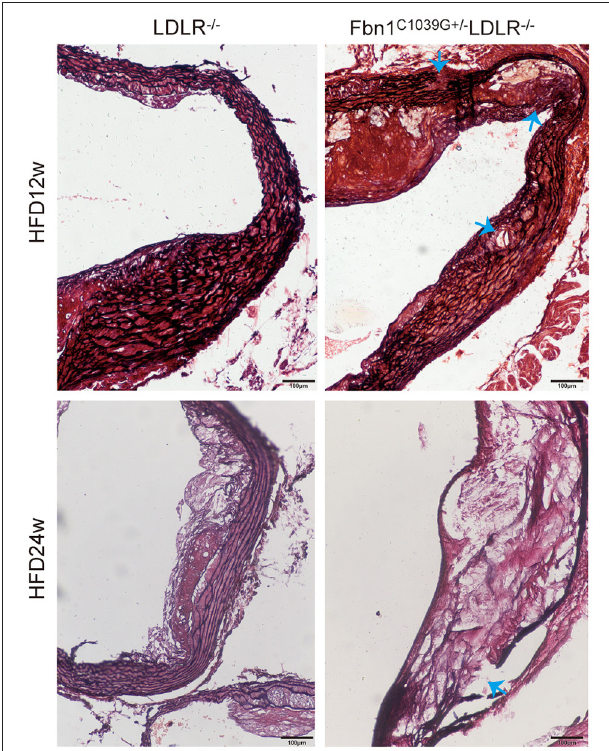
FIGURE 2 | Elastin fragmentation in Fbn1 C1039G + / − LDLR − / − mice. The arrow shows Elastin fragmentation in Fbn1 C1039G + / − LDLR − / − mice after 12 and 24w on a HFD, while elastin in LDLR − / − mice was intact. Movat staining: elastin is shown in black.